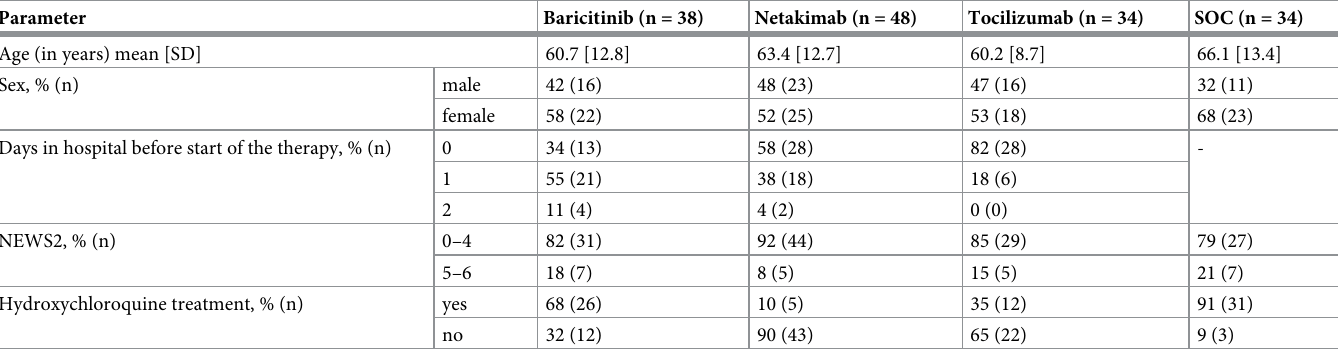
Table 1. General patient characteristics.